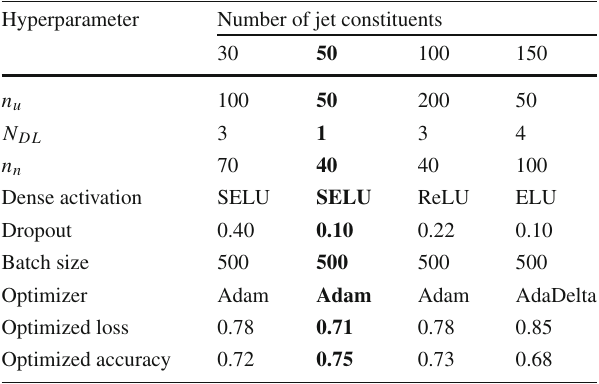
Table 6 Optimal GRU hyperparameter settings for different input data sets